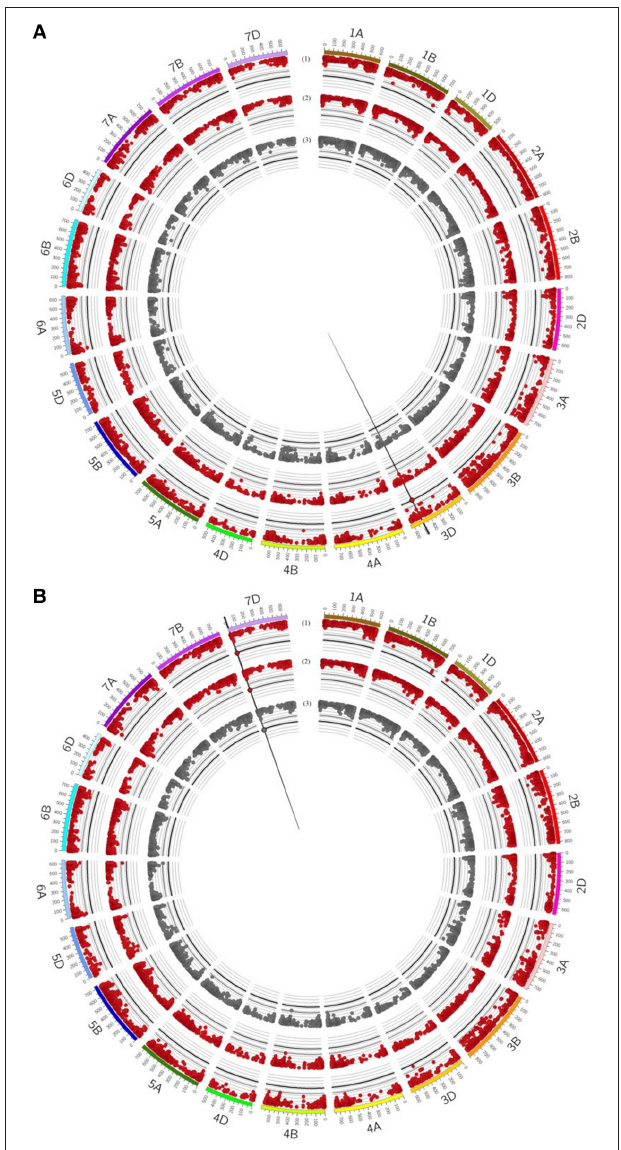
FIGURE 5 | Circos plot for relative mycorrhizal responsivness (MR), absolute mycorrhizal responsivness (R) and deviations ( δ ) from the regression line of (A) grain yield (GY) and (B) number of grains per ear (GN). Dark red (1 + 2) circles represent results of genome-wide association studies for MR and R under drought stress condition. Gray (3) circle represents results of genome-wide association studies for δ under drought stress condition. Genome-wide association study results of each trait pictured as Manhattan plot is based on 15511 polymorphic and mapped markers. Bold black line indicates threshold of significant marker trait associations with LOD 4.25. Significant marker trait associations are highlighted by black border. Vertical black lines highlight putative quantitative trait locus